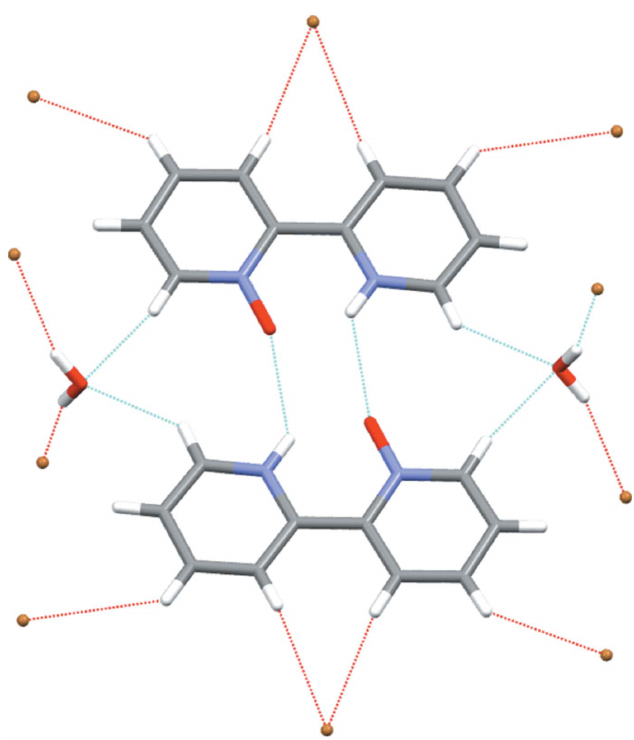
Figure 2 Dimer of cations formed by N—H (cid:2)(cid:2)(cid:2) O hydrogen bonds (Table 1). Hydrogen-bonded bromide anions and water molecules are also shown. Disorder of the cation is omitted for clarity.